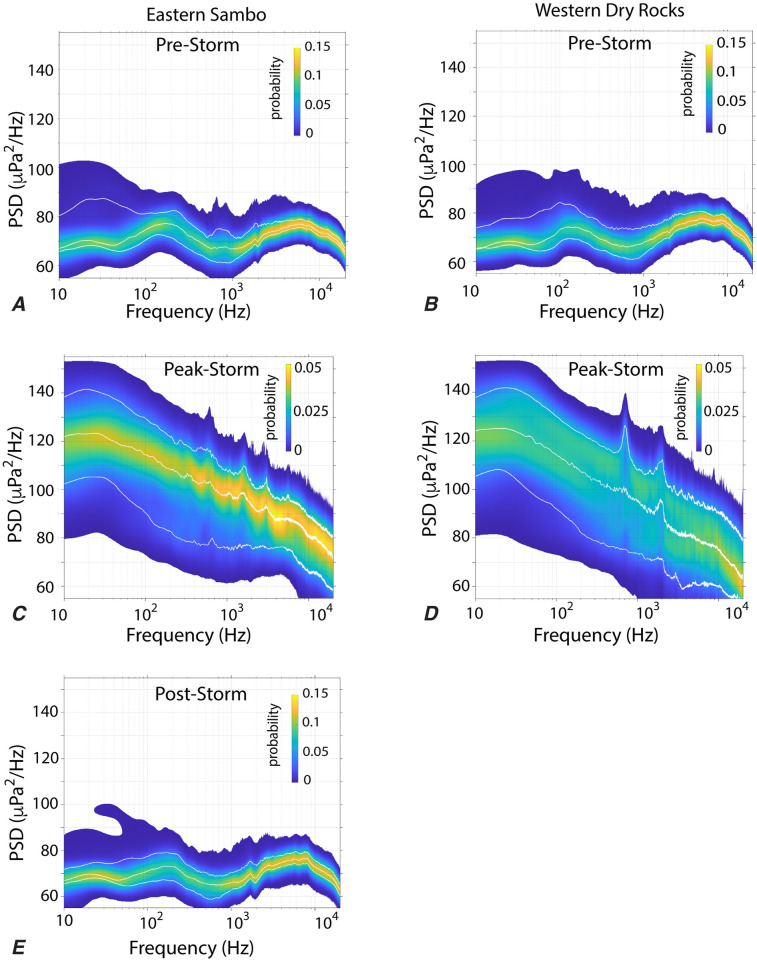
Power Spectral Density (PSD) plot.Power spectral density plot of Eastern Sambo (left) and Western Dry Rocks (right) pre-storm (A, B), peak-storm (C, D), and post-storm (E). The colors show the probability distribution of the spectral amplitudes, and white lines show the 5, 50, and 95% quantiles of power spectral density as a function of frequency.